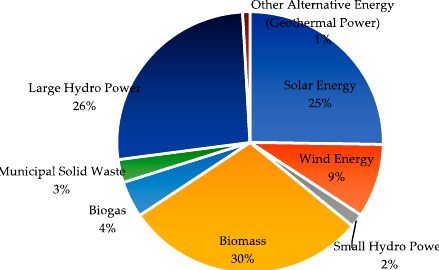
Figure 1. The proportion of electricity production from fuel and renewable energy sources in Thailand.